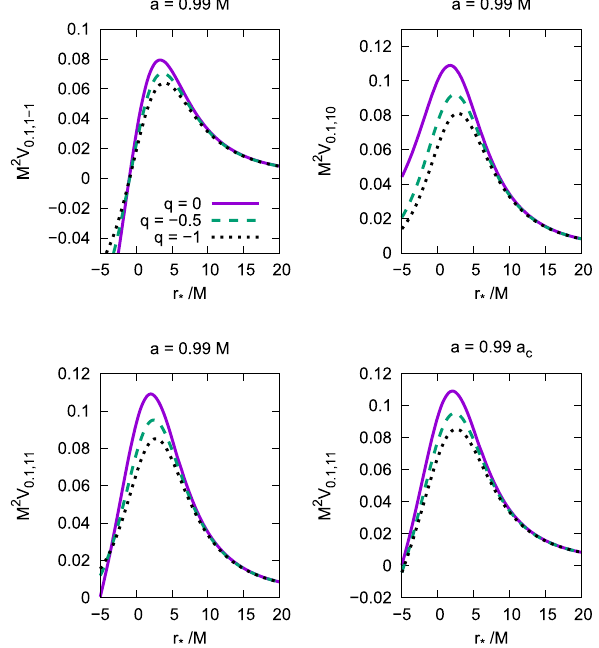
Fig. 2 Effective potential in terms of the tortoise coordinate for black holes with q = 0 , − 0 . 5 , − 1 and modes with l = 1 and M ω = 0 . 1. Top- left considering a = 0 . 99 M and m = − 1. Top-right for a = 0 . 99 M and m = 0. Bottom-left for a = 0 . 99 M and m = 1. Bottom-right comparing the cases of near-extreme black holes ( a = 0 . 99 a c ) and m =